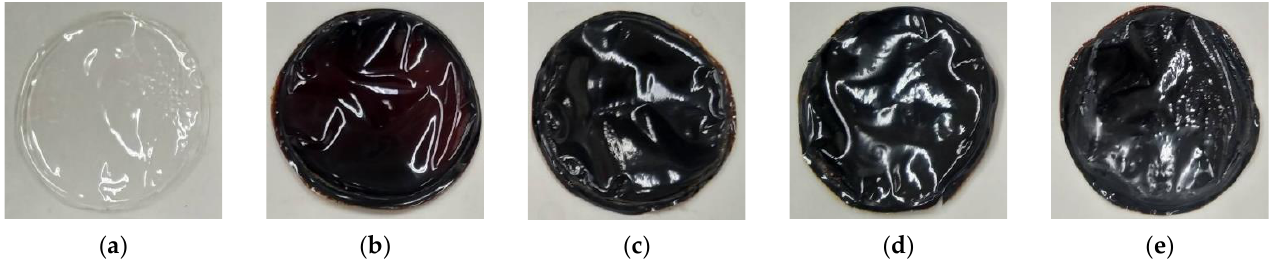
Figure 1. PVA composite films: ( a ) Neat PVA; ( b ) 80PVA/20LN; ( c ) 60PVA/40LN; ( d ) 40PVA/60LN; ( e ) 20PVA/80LN.